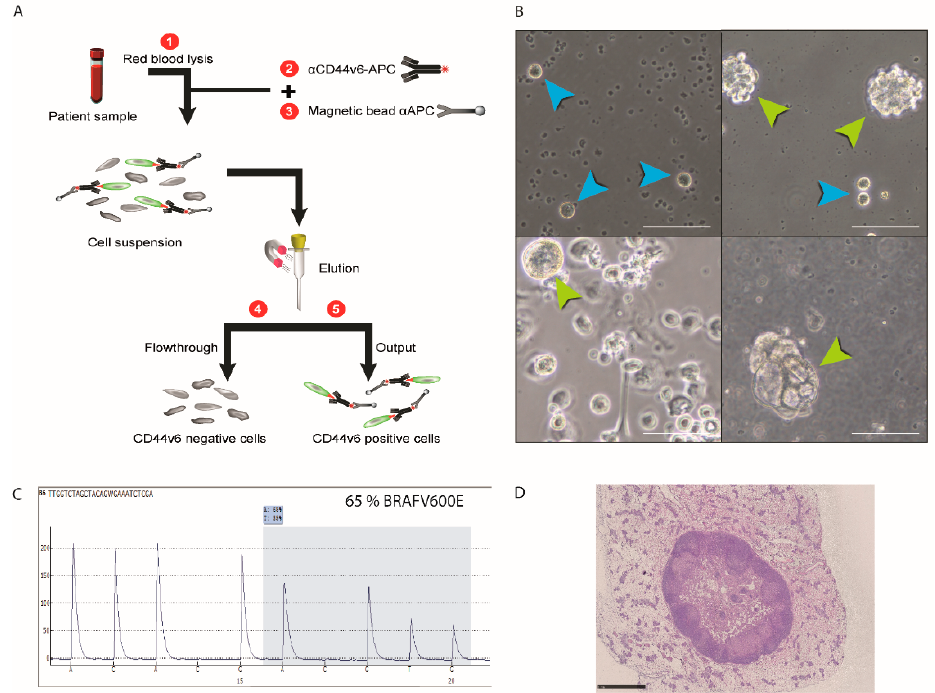
Figure 2. Magnetic bead-based isolation using an antibody directed against CD44v6 efficiently discriminated tumor cells from hematopoietic cells. ( A ) Schematic flowchart summarizing the strategy used to purify CTCs from blood using magnetic beads. Detailed protocol is described in the Materials and Methods section. APC stands for “Allophycocyanin”. ( B ) Photos of live cultured CTCs from four CRC patient blood samples following labelling with antibodies directed against CD44v6 and purification with magnetic beads. Blue arrowheads show single cells, and green arrow heads show spheres initiated from proliferative single cells. Scale bars represent 50 µ m. ( C ) Detection of the BRAF V600E mutation in the newly established CTC line by pyrosequencing is described in the Supplementary file S1. In the mutated samples, “A” at position 600 replaces “T”. ( D ) Hematoxylin/eosin staining on a subcutaneous tumor obtained after the novel CTC line was injected in the flank of a nude